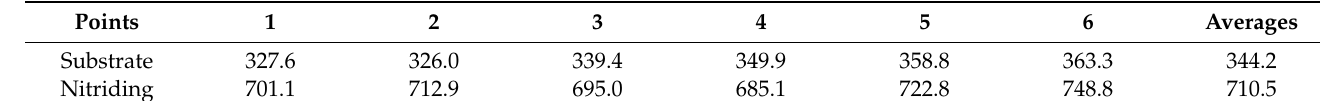
Table 3. Surface hardness of substrate and nitrided 4Cr10Si2Mo (Unit HV).